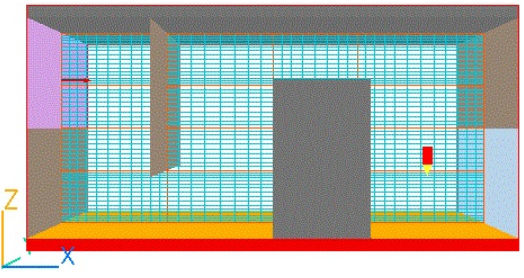
Figure 5. Grid automatically generated for labyrinth case.